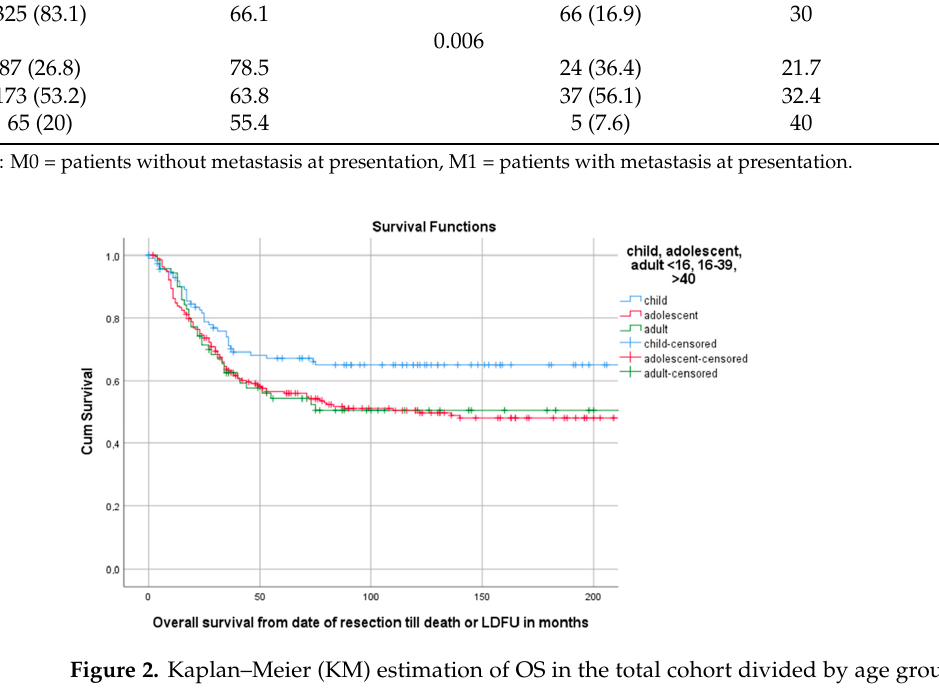
Table 2. Overall survival (OS) among different age groups with or without distant metastasis (DM) at presentation. Factors